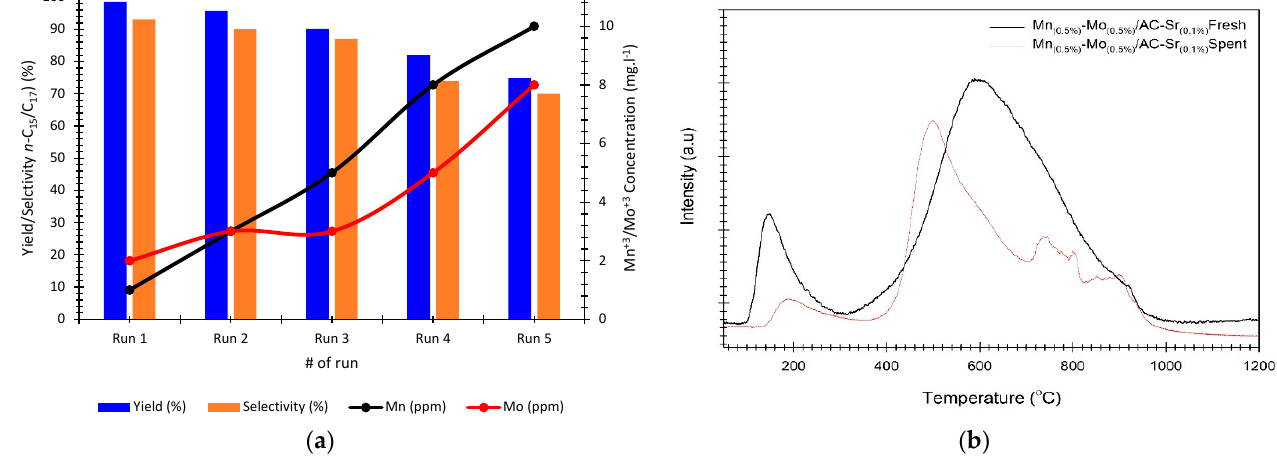
Figure 7. Catalyst stability and reusability study; ( a ) the catalyst reusability yield/selectivity and active element leaching at optimum condition and ( b ) acidity measurements of fresh and spent supported catalyst of Mn (0.5%) -Mo (0.5%) /AC.